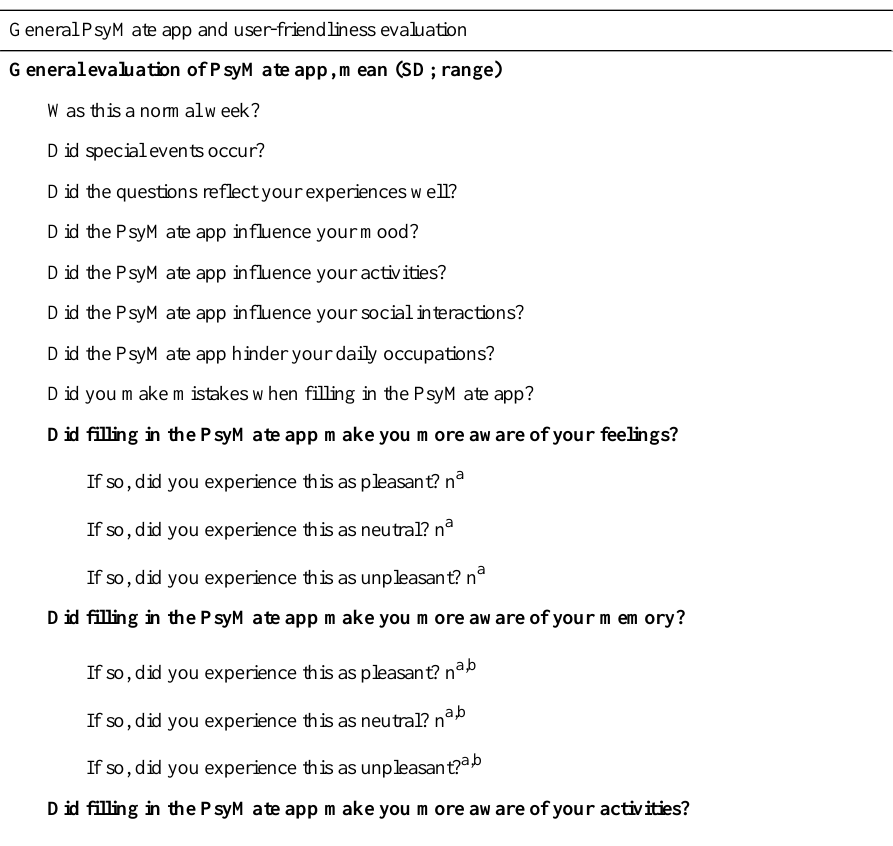
Table 2. General PsyMate app and user-friendliness evaluation [n=18; dropouts (n=3) were not included because they did not participate in the debriefing session].